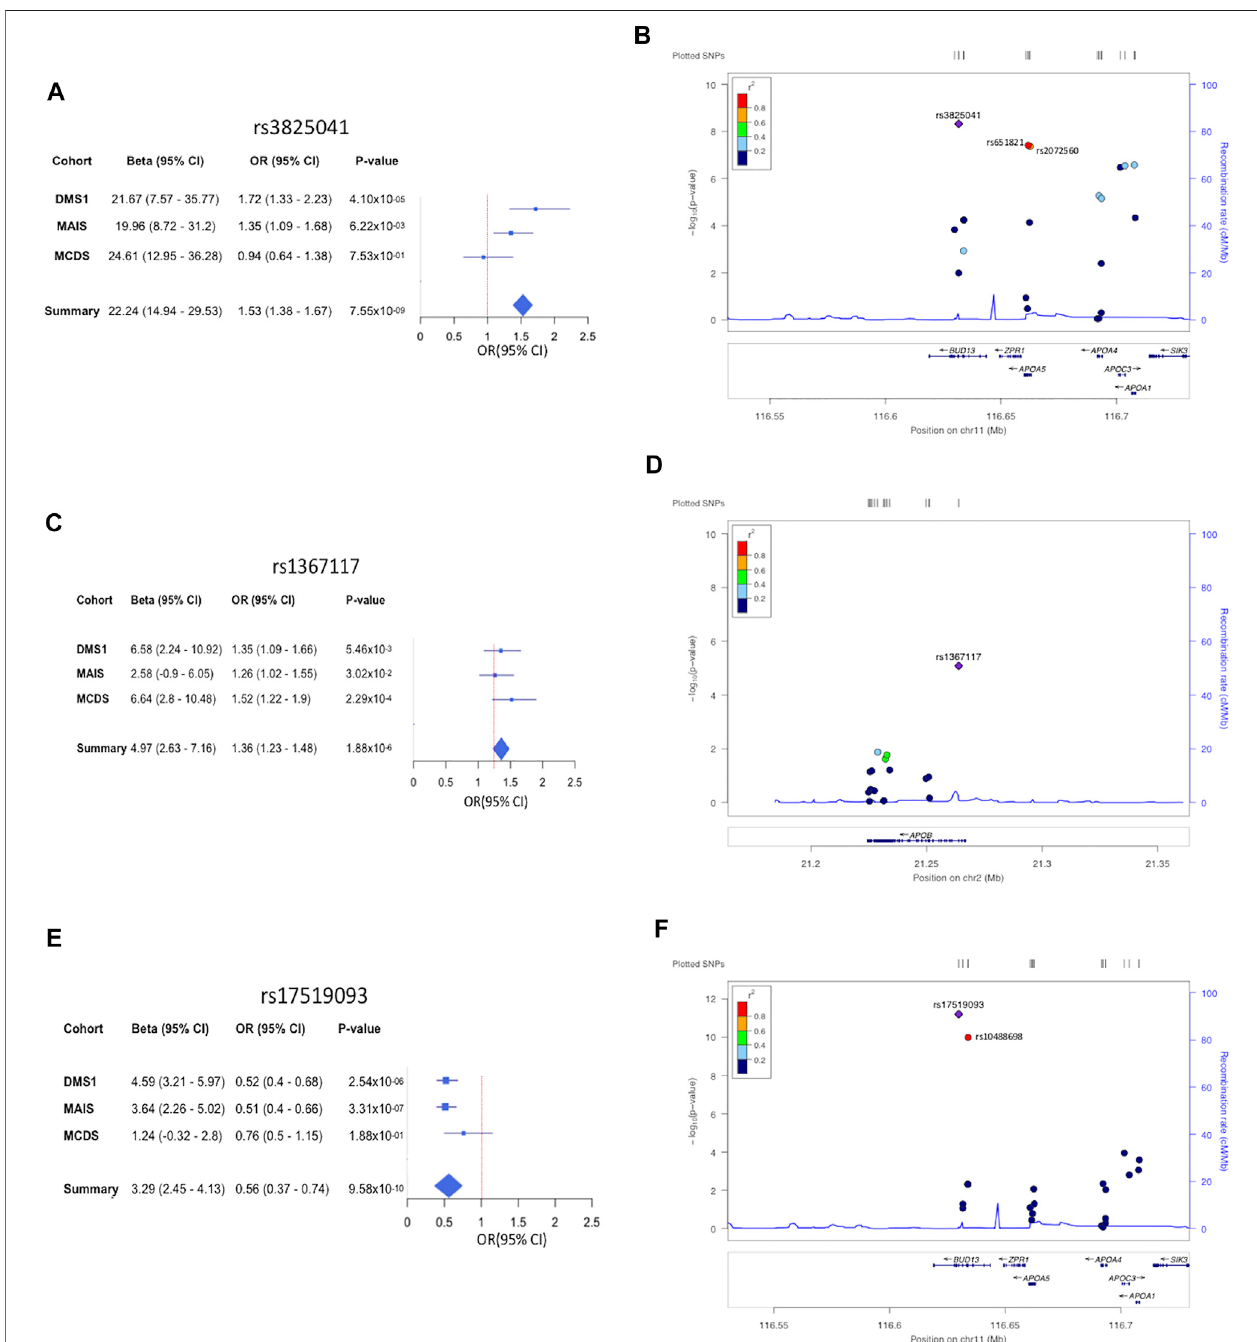
FIGURE 3 | Forest and regional plots showing the top hits associated with lipemic traits. Forest plot showing odds ratio estimates and 95% con fi dence intervals (squared boxes) from the 3 cohorts DMS, MCDS, and MAIS, included in the study in HTG (A) , HTC (C) , and low HDL-C (E) . Odds ratios for the meta-analyses are represented with a diamond. Regional plot of associated SNVs in HTG (B) , HTC (D) , and low HDL-C (F) .